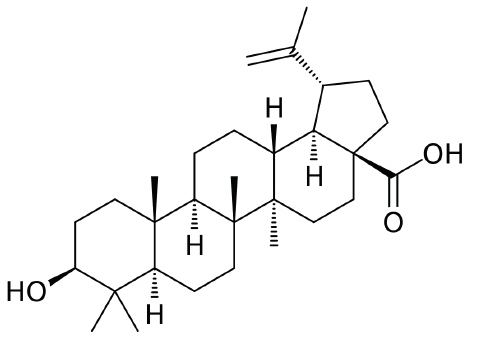
Figure 3: Chemical structure of betulinic acid (compound 1 ) isolated from Lycopus lucidus .